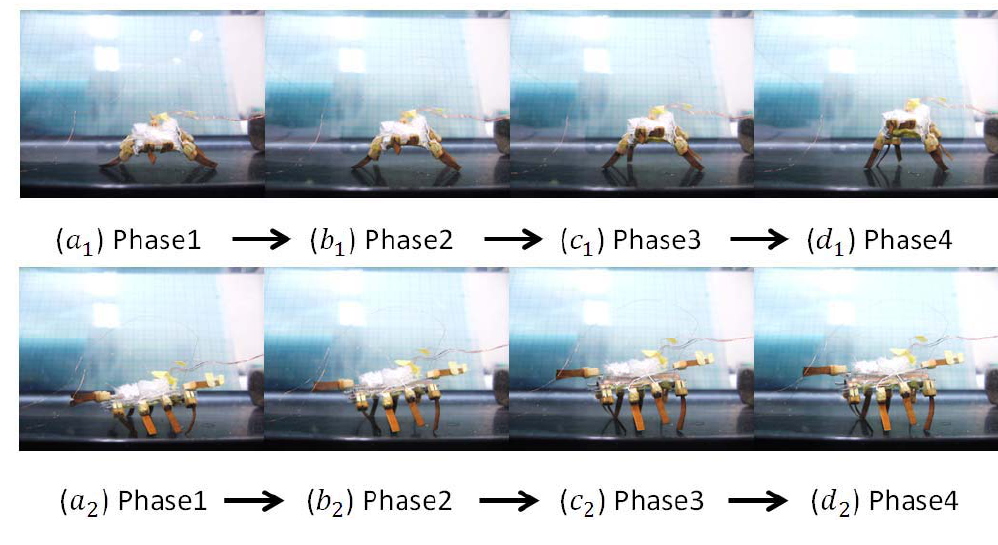
Figure 27. Standing experiments on the underwater